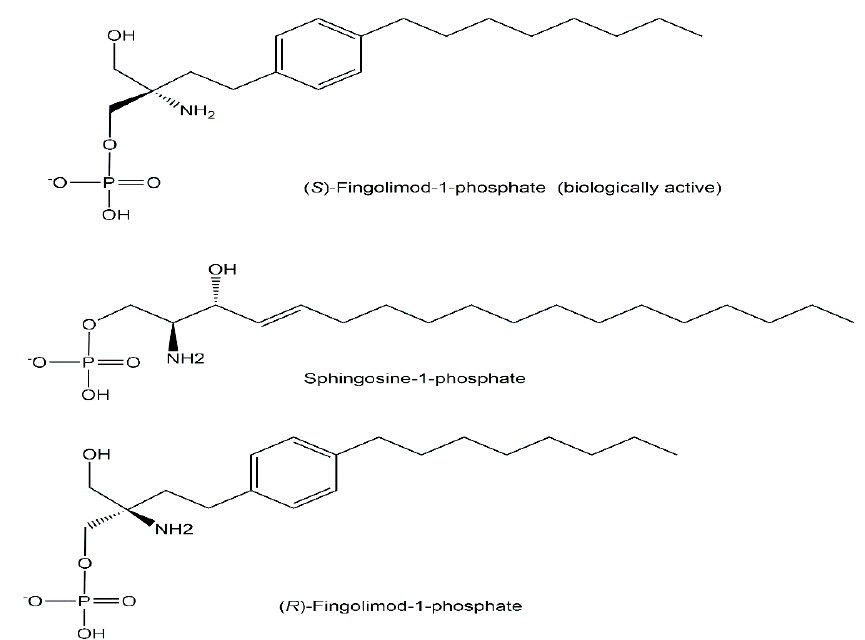
Figure 12. Biologically active non-natural ( S )-fingolimod 1-phosphate, natural sphingosine 1-phosphate as well as the ( R )-fingolimod 1-phosphate (not found in vivo).